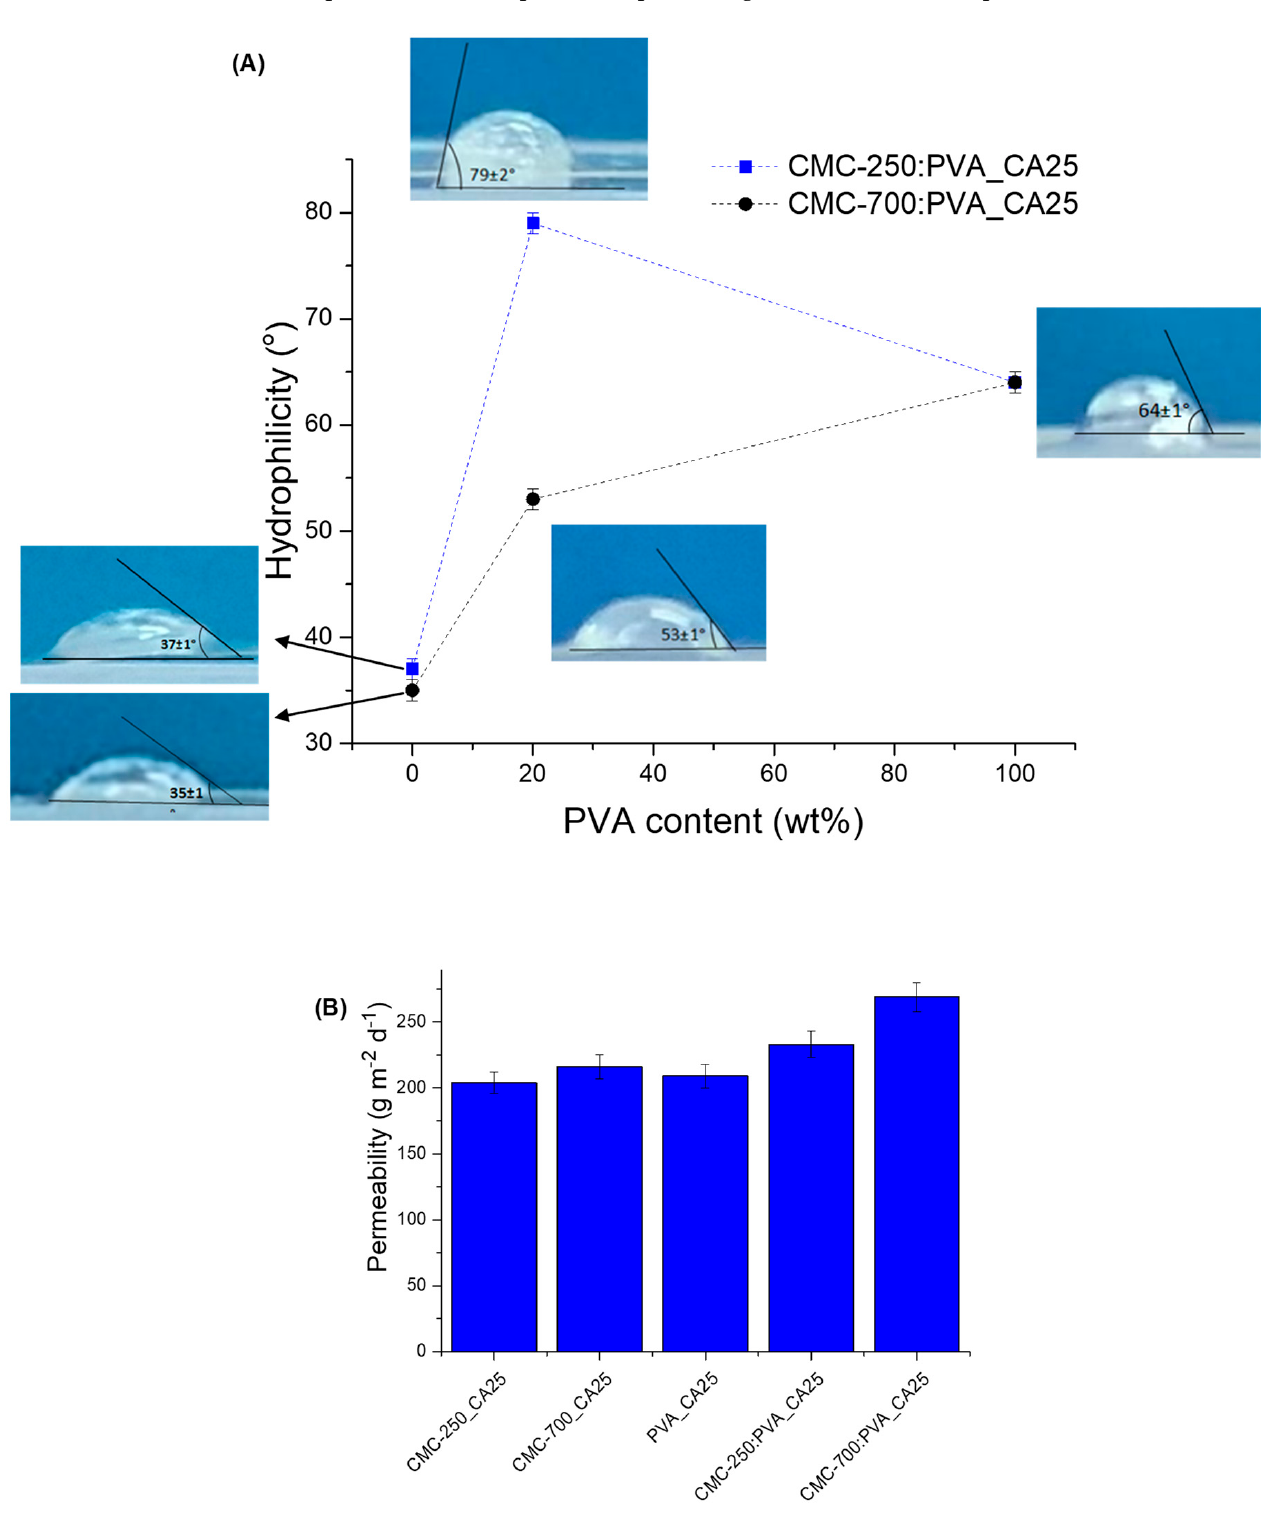
Figure 13. ( A ) Evaluation of wettability of crosslinked hydrogels (CA/polymer = 25%) based on the static contact angle measurements (sessile drop method), including typical digital images obtained for different systems under evaluation. ( B ) Permeability of crosslinked hydrogels.